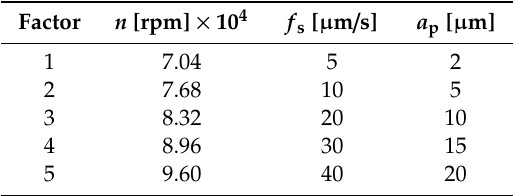
Table 2. Slot milling factor level code.